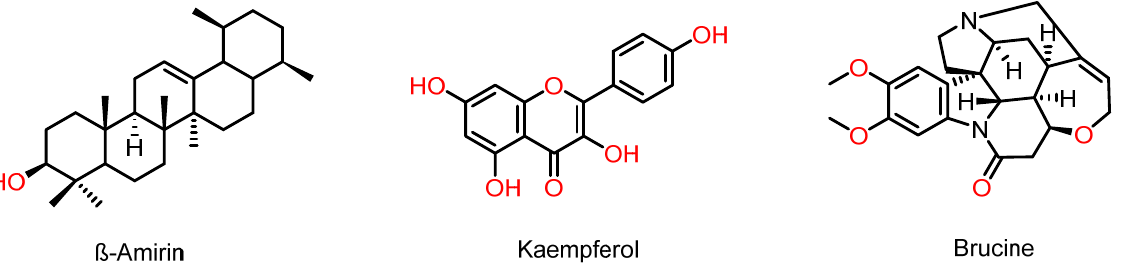
Figure 5. Molecular structures of secondary metabolites identi fi ed in the AM07Ac extract of the fungus Trichoderma asperellum.